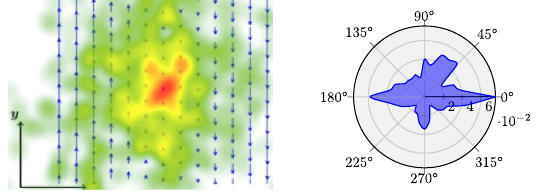
FIG. 4. Distributions of visual attention (left) and saccadic angles (polar plot, right) regarding the initial problem.